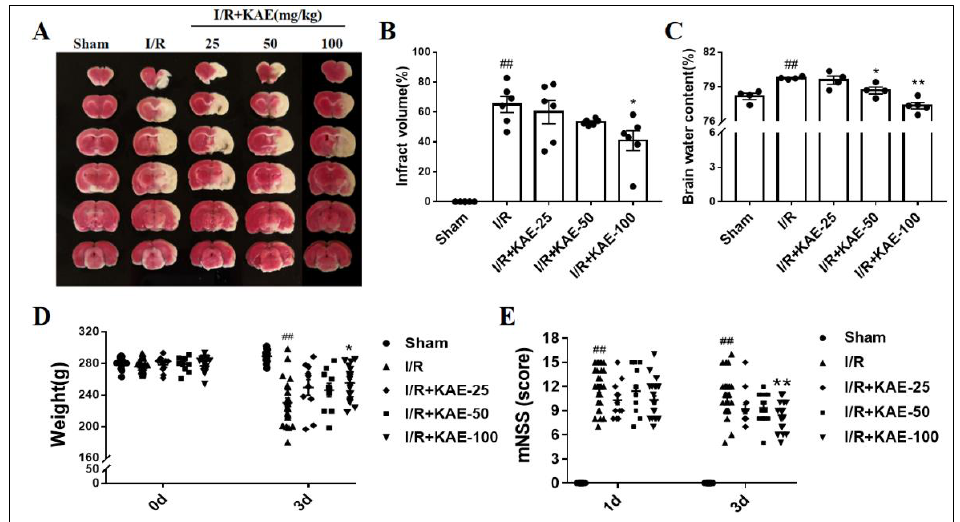
Figure 2. Effect of kaempferol on cerebral infarction volume, brain water content, weight and neurological function of rats on day 3 after cerebral ischemia-reperfusion. ( A ) Representative images of 2, 3, 5-triphenyltetrazolium chloride (TTC) staining. Statistical analysis of ( B ) infarct volume ( n = 6), ( C ) brain water content ( n = 6), ( D ) body weight ( n = 10 – 12) and ( E ) modified neurological severity score (mNSS) score ( n = 10 – 12). Values are expressed as mean ± SEM. ## p < 0.01 vs. Sham group; * p < 0.05, ** p < 0.01 vs. I/R group. KAE: kaempferol.